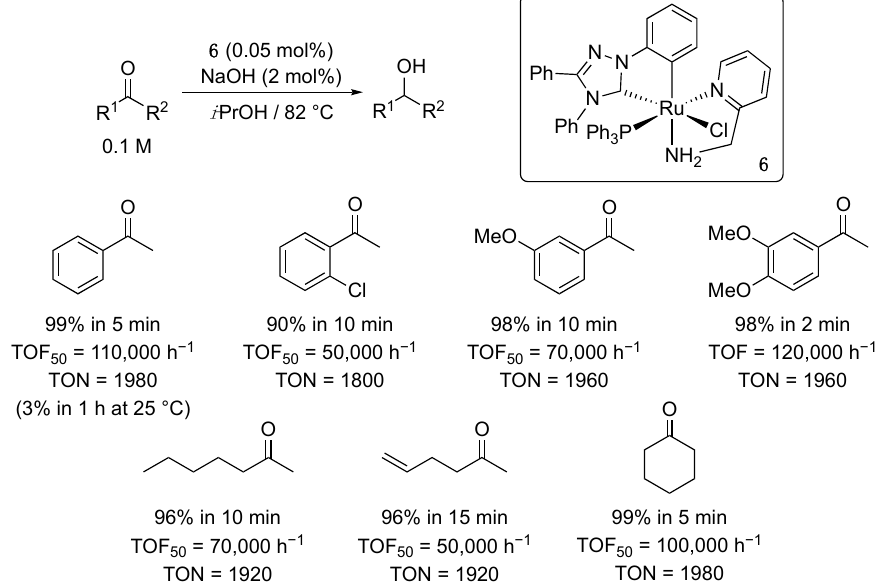
Figure 1. Bimetallic complexes 7 and 8 bearing a CC -cyclometalated NHC-pyridyl or NHC-phenyl ligand.